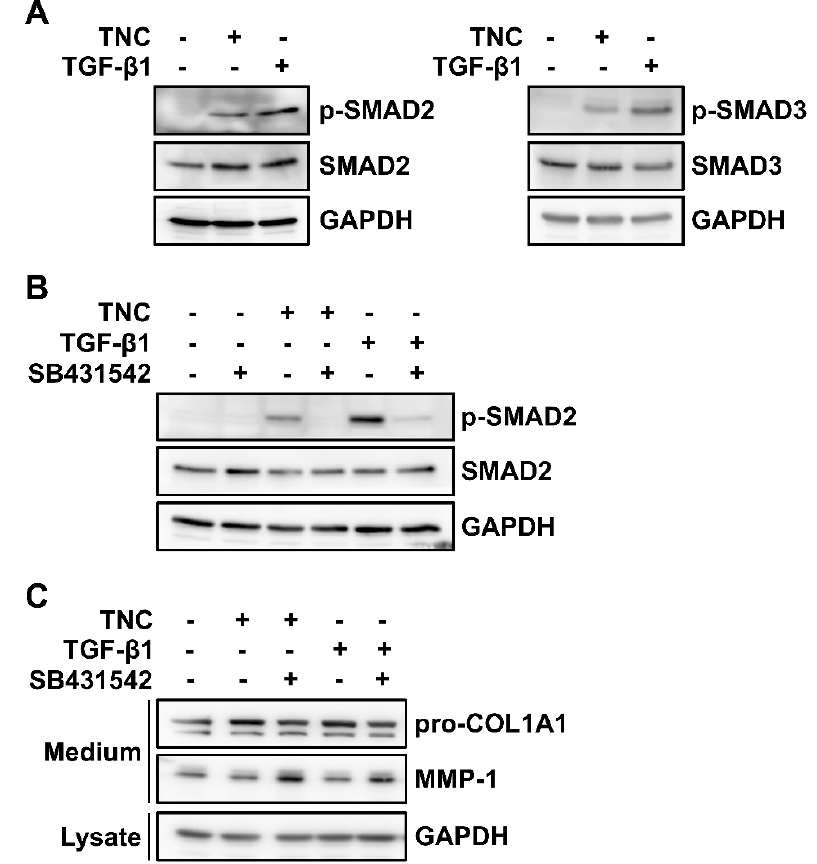
Figure 4. Analysis of receptor-regulated SMAD activation by TNC in fibroblasts. ( A ) Subconfluent human foreskin fibroblasts were starved for 12 h and then incubated with TNC (2 µg/mL) or TGF- β 1 (3 ng/mL) for 90 min. Cell lysates were analyzed by western blotting using antibodies against phospho-SMAD2 (p-SMAD2), SMAD2, phospho-SMAD3 (p-SMAD3), SMAD3, and GAPDH. ( B ) Serum-starved foreskin fibroblasts were preincubated with SB431542 (10 µM) for 10 min and then stimulated with TNC (2 µg/mL) or TGF- β 1 (3 ng/mL) for 90 min. Cell lysates were analyzed by western blotting with antibodies against p-SMAD2, SMAD2, and GAPDH. ( C ) Serum-starved foreskin fibroblasts were stimulated with TNC (2 µg/mL) or TGF- β 1 (3 ng/mL) in the presence of SB431542 (10 µM) for 24 h. Levels of type I collagen and MMP-1 in conditioned media and GAPDH in cell lysates were evaluated by western blot analysis using antibodies against pro-COL1A1, MMP- 1, and GAPDH.